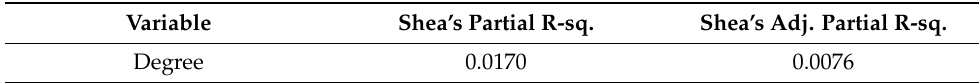
Table 6. Shea’s partial